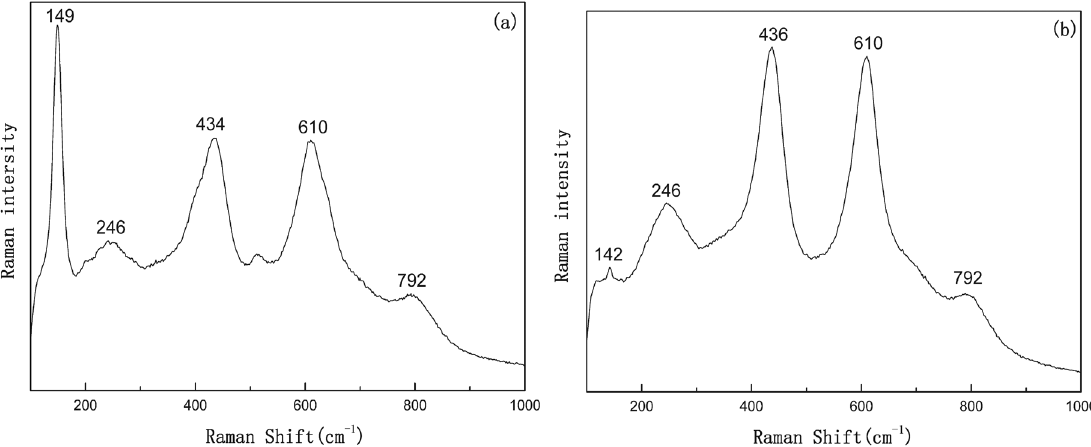
Fig. 6: Raman spectra for roasted product: (a) 773 K roasted; (b) 1223 K